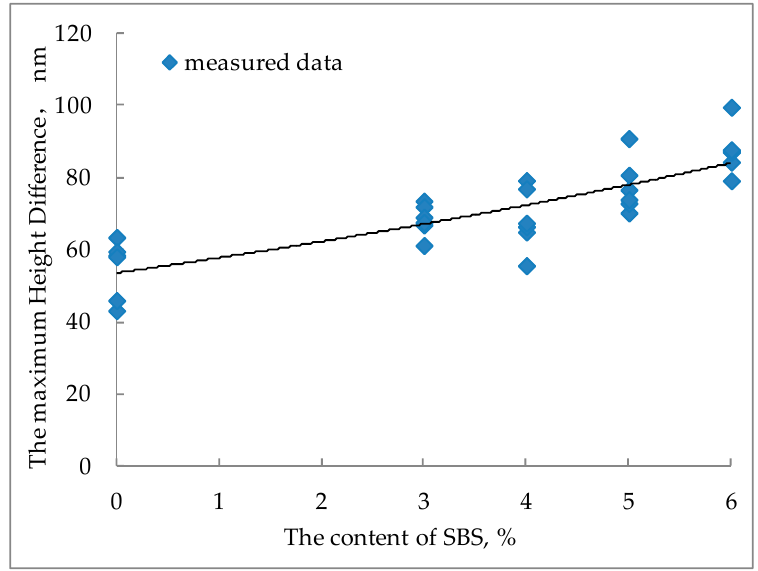
Figure 9. Maximum height difference of modified bitumen with different SBS content.